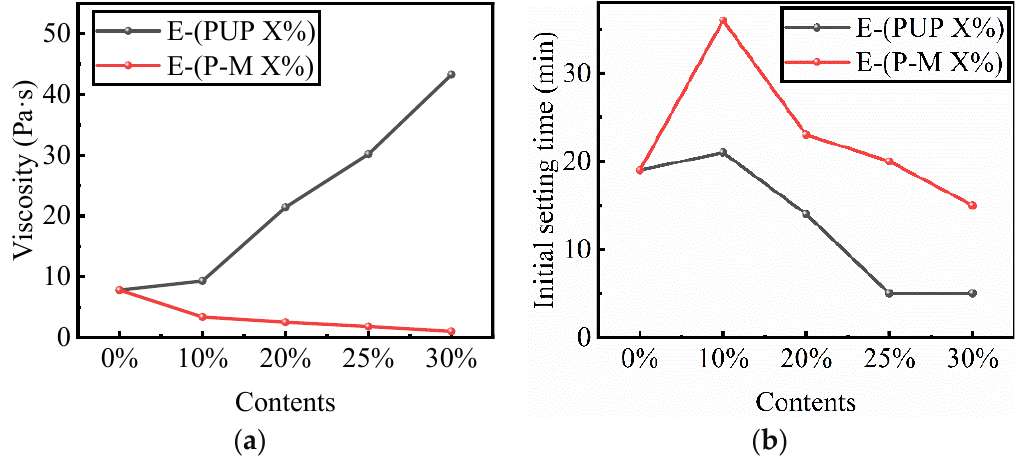
Figure 3. Viscosity and initial setting time of the modified EP. ( a ) Viscosity, ( b ) initial setting time.